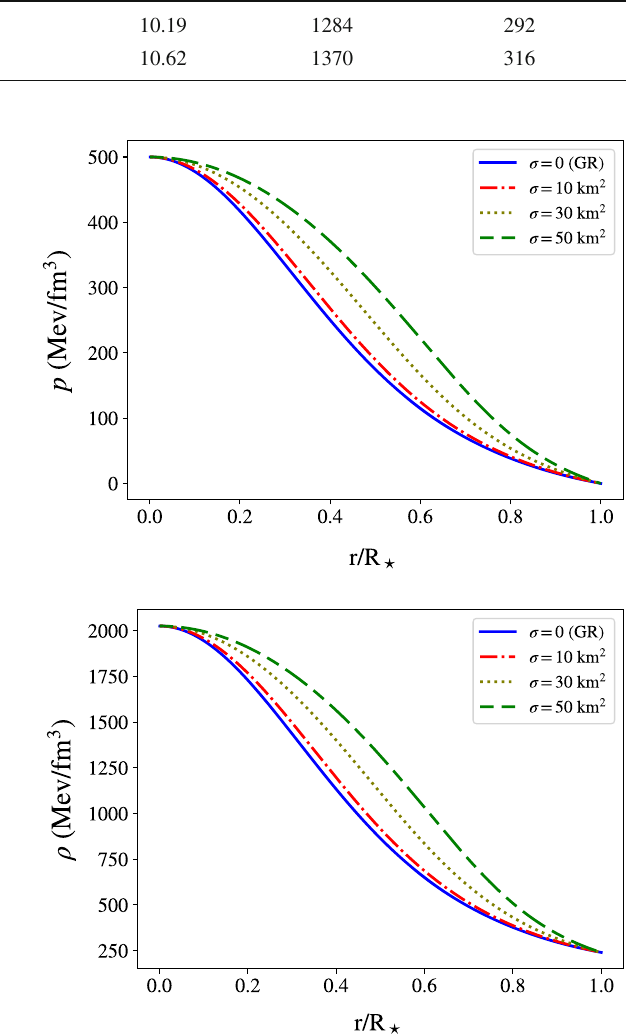
Fig. 3 Compactness and surface red-shift as function of the star’s cen- tral energy density Fig. 4 Profiles of pressure and energy density inside a quark star with central pressure of 500 MeV/fm 3 . This is an example to illustrate that the GMC theory yields to well-behaved scenarios, where it is straight- forward to show that energy conditions are respected